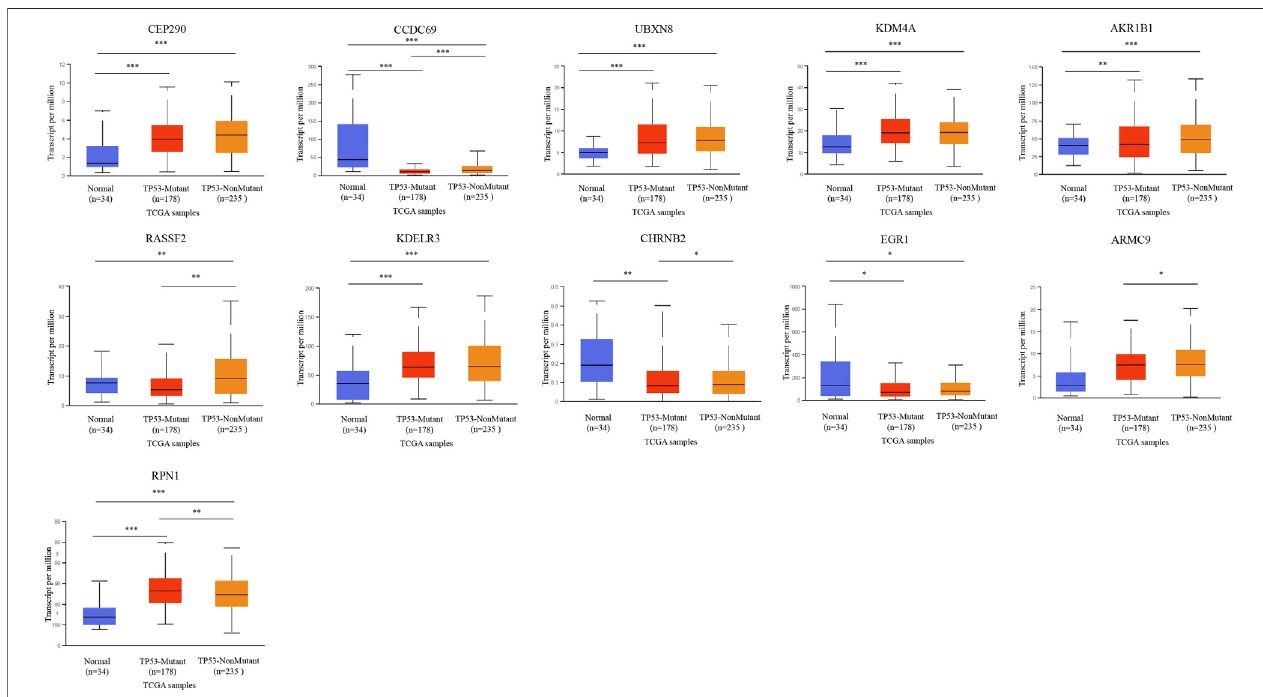
FIGURE 8 | The relationship between 11-DMG mRNA expression levels and TP53 mutation in gastric cancer (GC) (mutation: red, non-mutation: orange, and normal gastric tissues: blue) (UALCAN) (* p < 0.05, ** p < 0.01, *** p < 0.001).